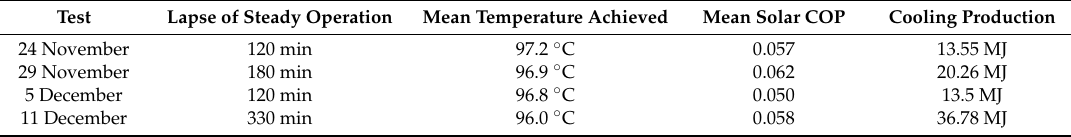
Table 6. Values for a daily operation of the combined